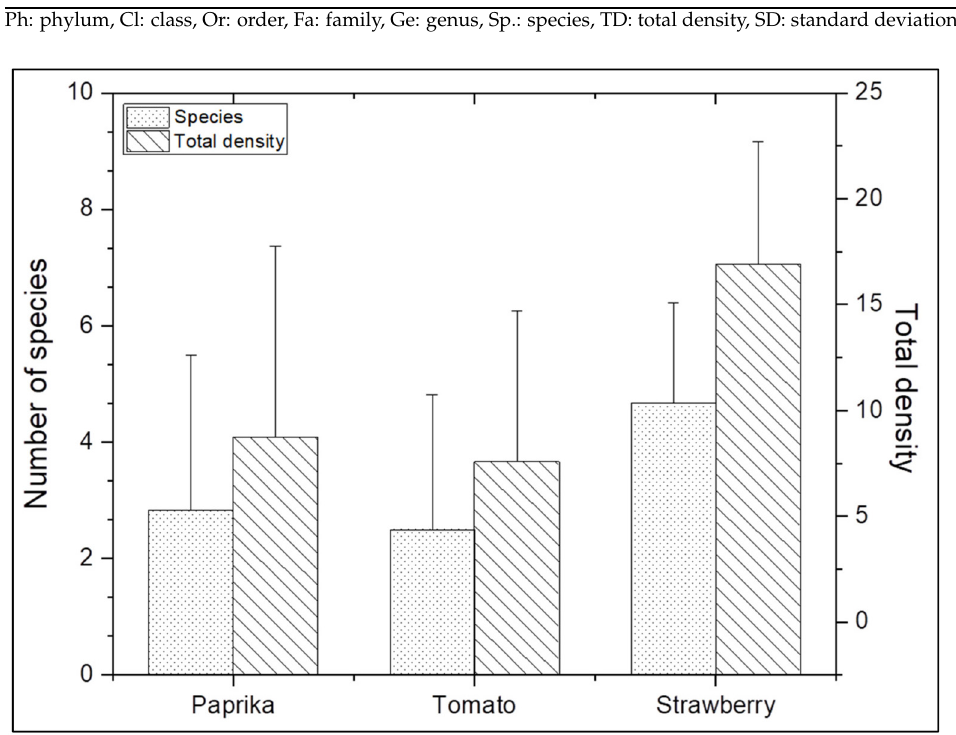
Figure 2. Average density of fungi detected at 36 study sites according to cultivated